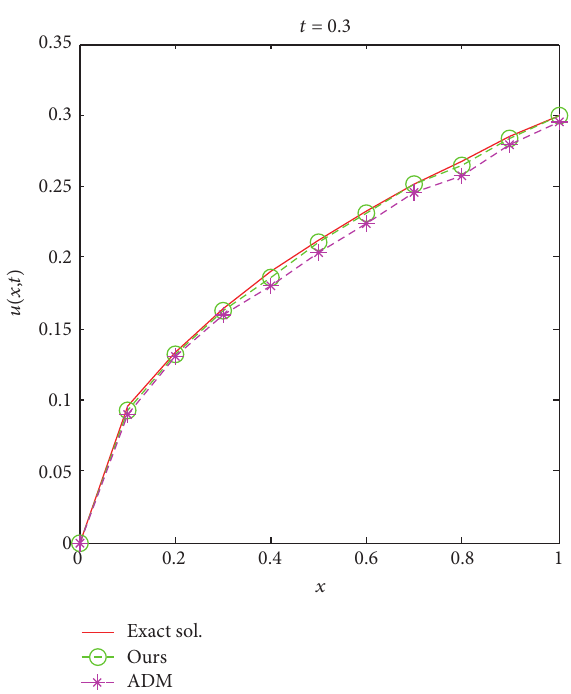
Figure 5: The comparison between FLFM and ADM with 𝑚 = 3, 𝑛 = 3 for Example